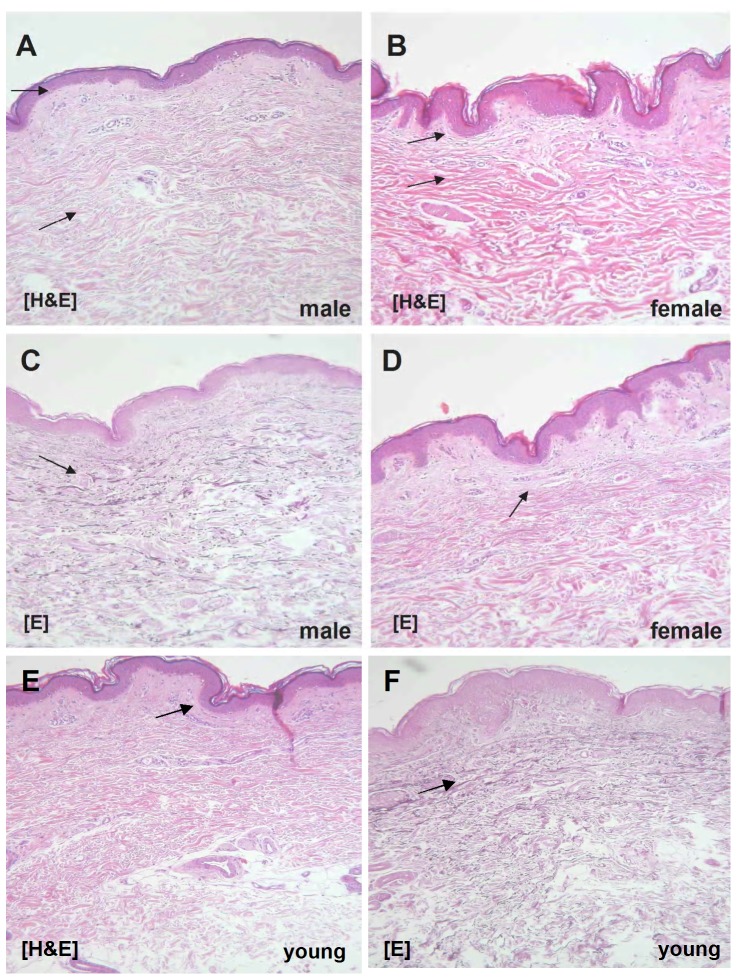
A comparison between male (A, C) and female (B, D) endogenous aged skin.Staining via hematoxylin eosin (A, B) and elastica staining (C, D), respectively, revealed that the dermis in the male is significantly thicker than in the female. In contrast, epidermis and subcutaneous tissue are significantly thicker in the female. Skin derived by a young donor after hematoxylin (E) and elastica (F) staining.